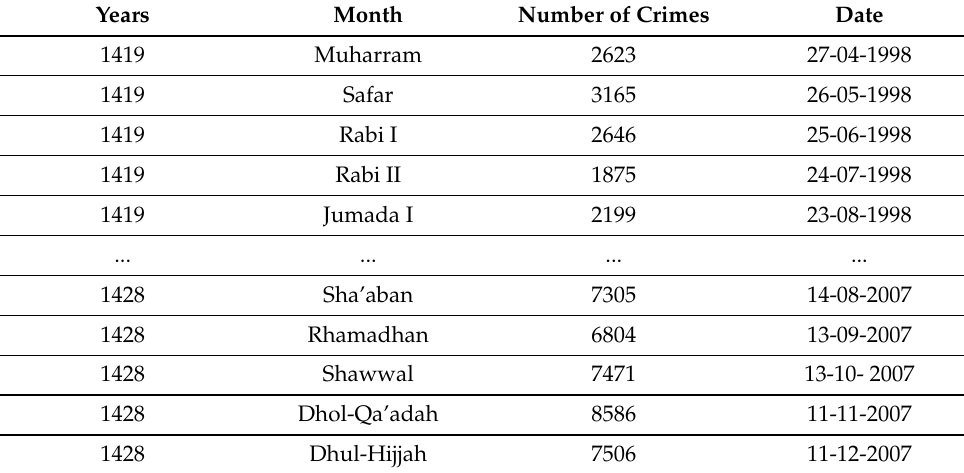
Table 1. Total number sample of crimes for each month in